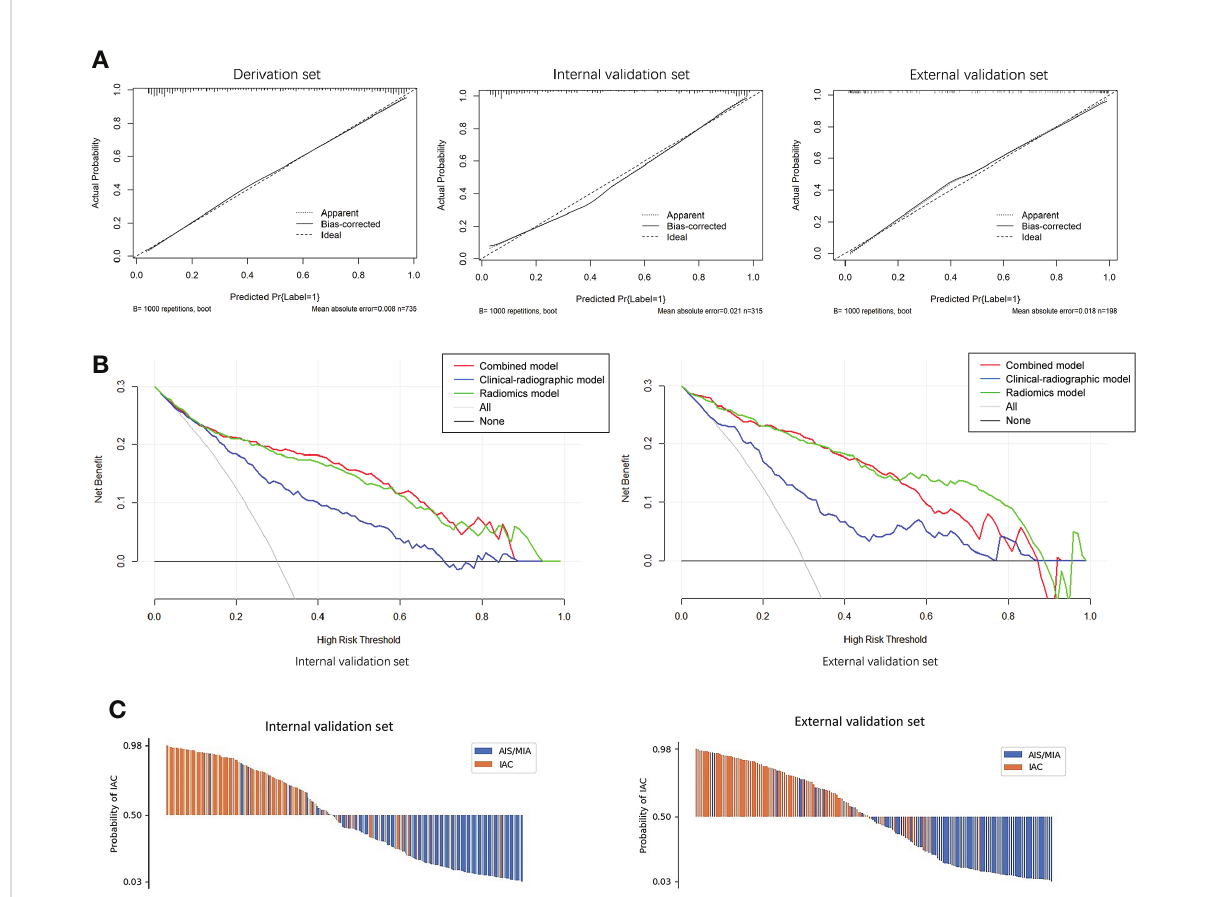
FIGURE 6 (A) Calibration curves of the combined model indicated good agreement between the predicted probability and actual occurrence in the derivation, internal validation, and external validation sets. (B) Decision curve analysis on both the internal and external validation sets for the models with and without Rad-score. It can be seen that if the threshold probability of a patient is in the range of 0.10~0.85, using a model with the Rad-score to predict the invasive lesion would be more bene fi cial than using one without the Rad-score. (C) Waterfall plot of the combined model showing the predicted probabilities of internal and external validation sets. It can be seen clearly that the combined model can differentiate IAC from AIS/MIA